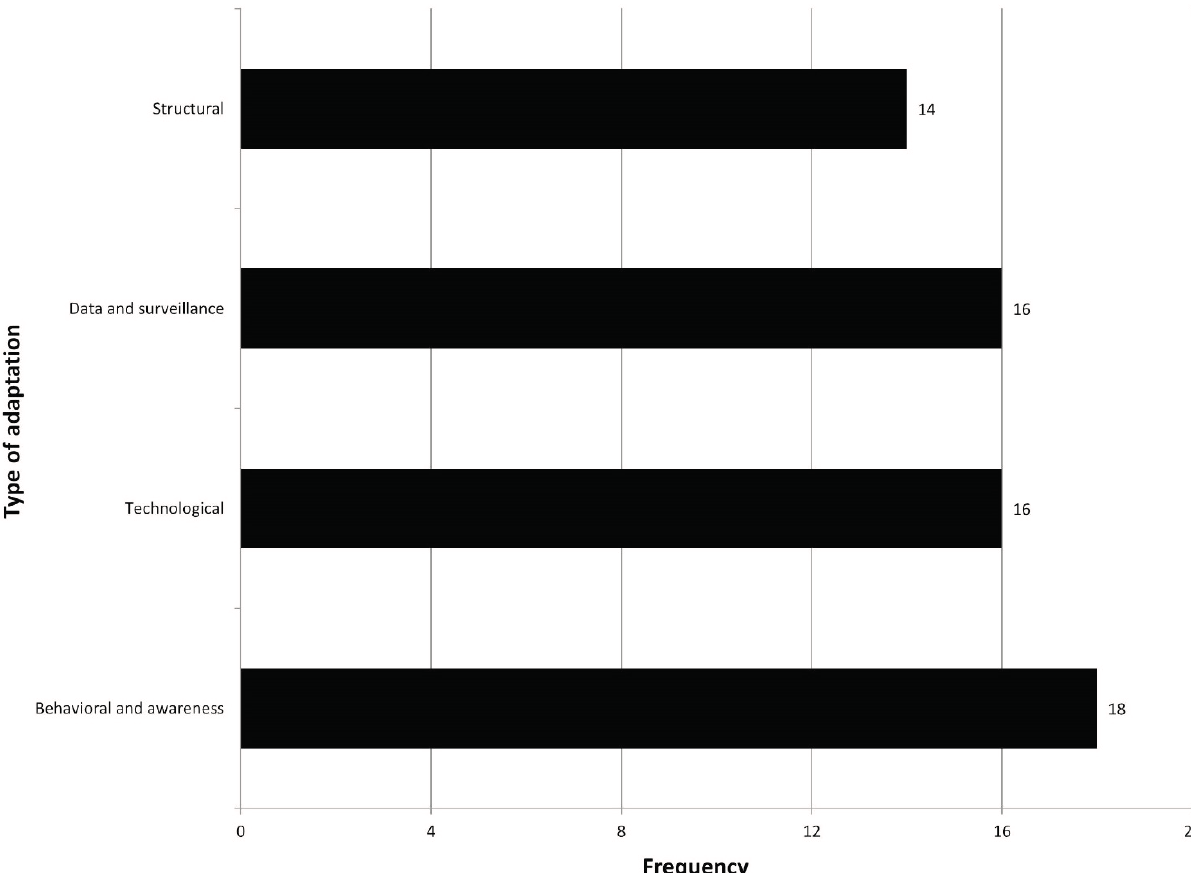
Figure 3. Types of adaptation proposed by strategy documents ranked by most frequent inclusion in strategy documents (more than one adaptation type was mentioned in each